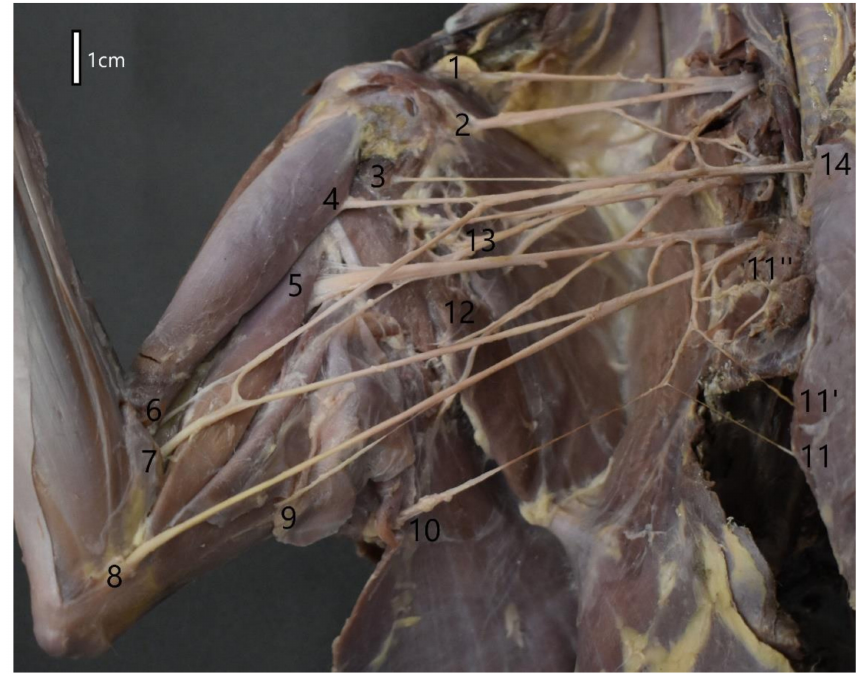
Figure 2. Structure of the right brachial plexus of the red fox ( Vulpes vulpes ). 1—Brachiocephalic nerve; 2—Suprascapular nerve; 3—Branch of the musculocutaneus nerve to coracobrachialis muscle; 4—Branch of the musculocutaneus nerve to biceps muscle of the arm; 5—Radial nerve; 6—Musculocutaneus nerve; 7—Medial nerve; 8—Ulnar nerve; 9—Part of the caudal antebrachial cutaneus nerve; 10—Lateral thoracic nerve; 11,11 (cid:48) ,11 (cid:48)(cid:48) —Caudal pectoral nerves; 12—Thoracodorsal nerve; 13—Axillary nerve; 14—Cranial pectoral